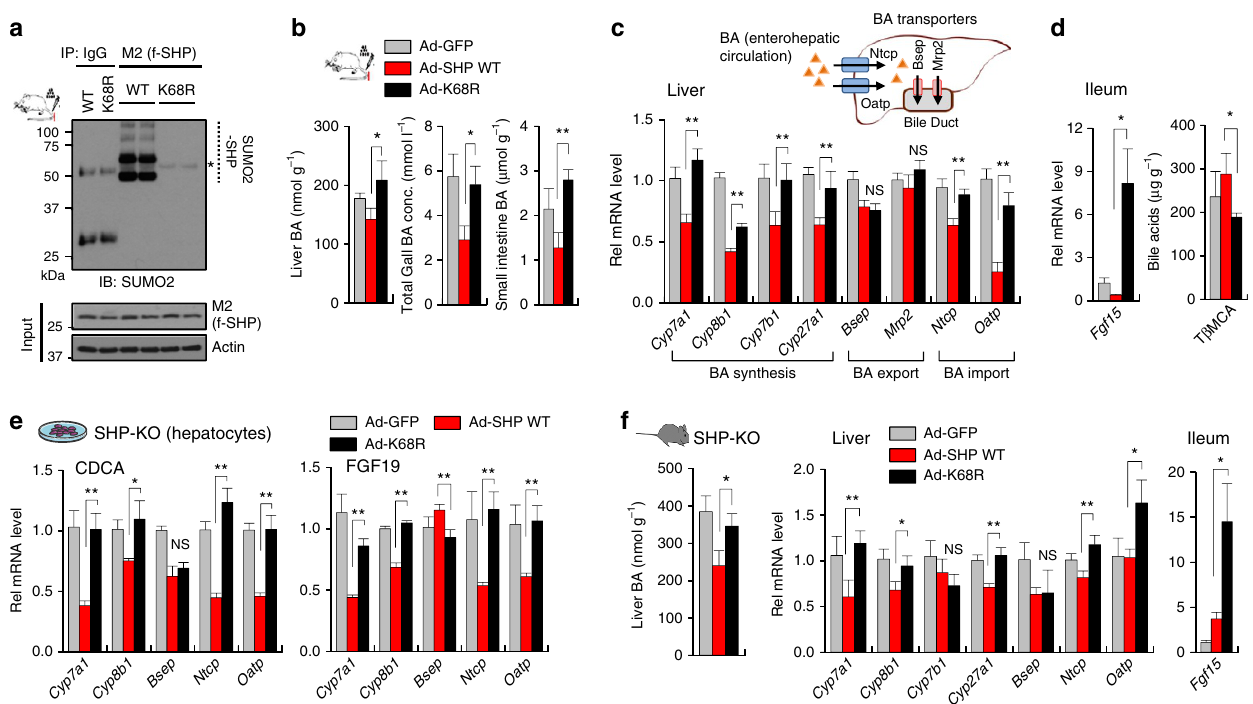
Figure 6 | Effects of SUMOylation of SHP on BA regulation in mice without biliary insults. ( a – d ) Mice were tail vein injected with Ad-GFP, SHP WTor K68R mutant, and 3 weeks later, serum and tissues were collected. ( a ) In vivo SUMO assay: Flag-tagged SHP in liver extracts was immunoprecipitated with M2 antibody. SUMOylated SHP in the immunoprecipitates was detected by IB with SUMO2 antibody. ( b ) The levels of BAs in the liver, gall bladder or intestine were determined and values are expressed per gram tissue weight. ( c ) quantitative qRT-PC: Liver BA transporters are illustrated (top). The mRNA levels of the indicated genes in the liver were measured by qRT-PCR. ( d ) The mRNA levels of intestinal Fgf15 and T b MCA levels in the intestine. ( e ) WT- SHP or the K68R mutant was expressed in hepatocytes isolated from SHP-KO mice, and expression of indicated genes was measured by qRT-PCR. ( f ) SHP- WTor the K68R mutant was adenovirally expressed in SHP-KO mice and liver BA levels, and expression of indicated genes were measured. The values for WT SHP are set to 1. Values represent mean ± s.e.m. Statistical significance was determined by the Student’s t -test, ( n ¼ 5 mice, * P o 0.05, ** P o 0.005, and NS, statistically not significant). qRT-PCR, quantitative real-time